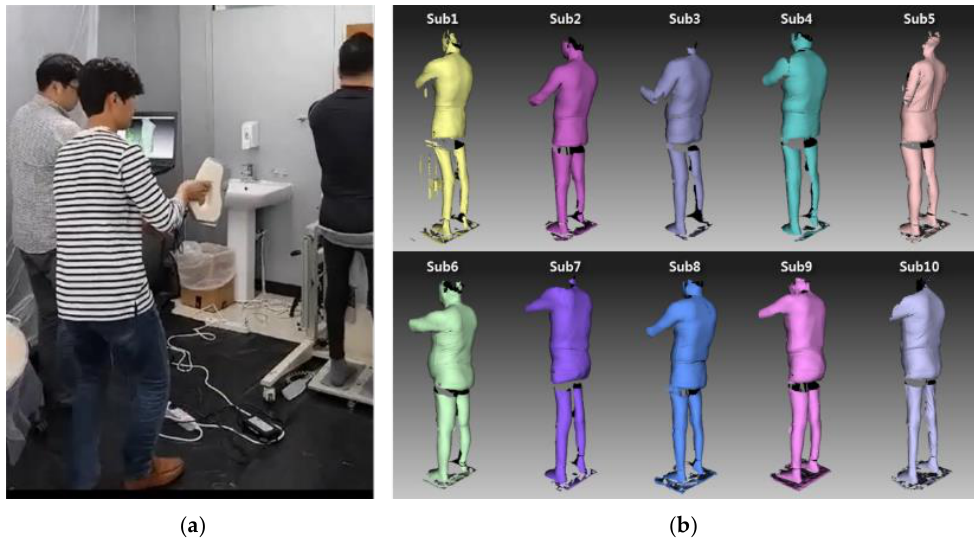
Figure 12. Secure human body shape data: ( a ) 3D scanning of human body shape and ( b ) 10 subjects’ human body shape data.